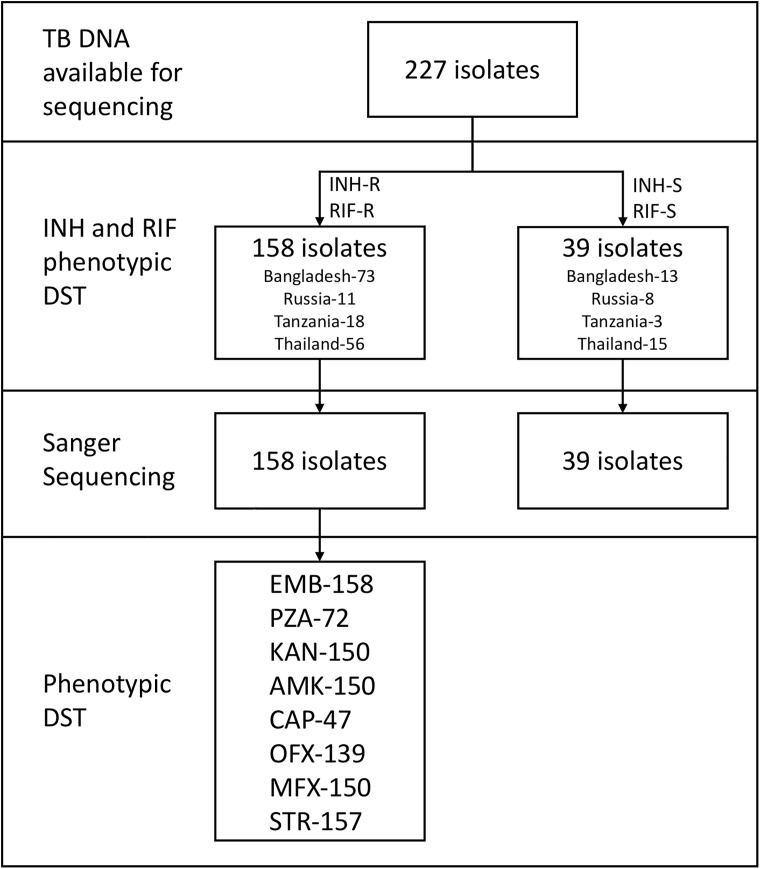
Isolate selection and description.A total of 227 tuberculosis genomic DNA extracts were available from a set of isolates that were characterized by phenotypic drug susceptibility testing. Isolate DNAs were selected for Amplicon NGS on the basis of the isolate being phenotypically characterized as MDR (INH-R RIF-R) or susceptible (INH-S RIF-S). Shown are the numbers of isolates with available data for Sanger sequencing and further phenotypic drug susceptibility testing for ethambutol (EMB), pyrazinamide (PZA), kanamycin (KAN), amikacin (AMK), capreomycin (CAP), ofloxacin (OFX), moxifloxacin (MFX), and streptomycin (STR).